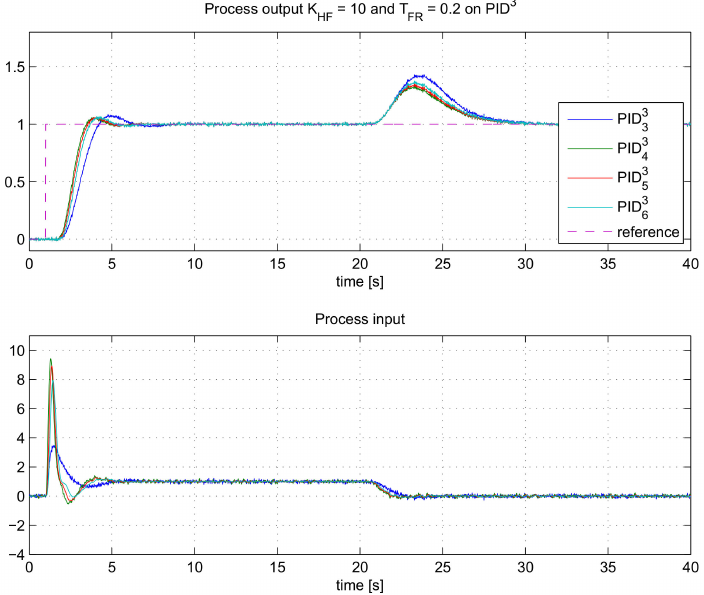
Figure 8. The closed-loop responses for the process G P 3 ( s ) when using controllers with different filter orders PID 3 n , at K HF =